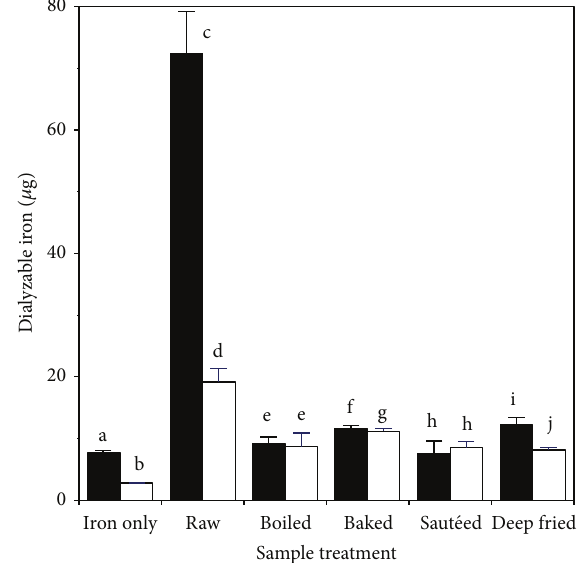
Figure 6: Effect of heating on production of dialyzable iron during digestion and extraction of chicken muscle: ◼ digestion; ◻ extraction. Values are the mean ± standard deviation ( 𝑛 = 10 ). Means in the same treatment group ( ◼ and ◻ ) without a common letter differ at 𝑃 < 0.05